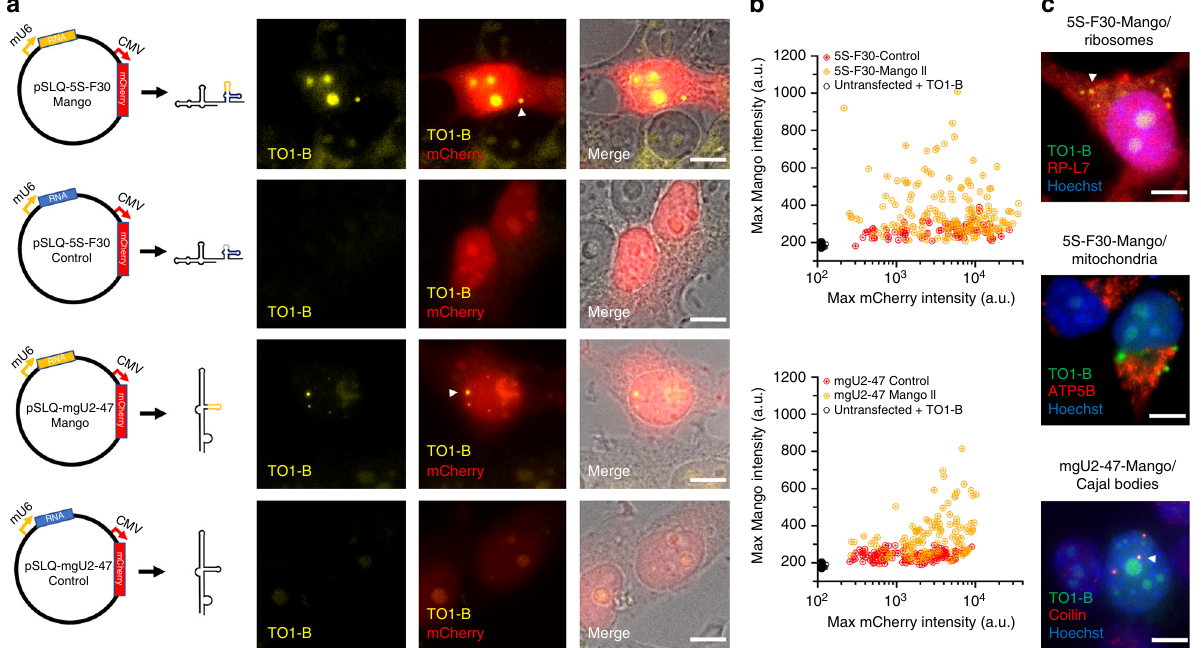
Fig. 5 Cellular imaging of genetically encoded Mango II-tagged RNAs. a Diagram of plasmid constructs with the 5S rRNAs and mgU2-47 scaRNAs under the control of a murine U6 promoter (Pol III) and co-expression of a mCherry reporter gene (CMV promoter). Shown adjacent are images of individual slices of fi xed cells either expressing Mango II-tagged RNAs (top) or control RNAs (bottom) with the TO1-B (200 nM) signal in yellow, mCherry in red and bright fi eld image in greyscale. Arrows depict signi fi cant cellular and nuclear foci. Scale bar = 10 µ m. b 2D maximum intensity plots of individual nucleoli and Mango II speci fi c foci for both the TO1-B signal ( y axis) and mCherry signal ( x axis — log 10 scale). The number of cells for 5S-F30-Control, 5S-F30-Mango II, untransfected cells + TO1-B, mgU2-47 Control and mgU2-47 Mango II were 89, 167, 98, 130 and 117 respectively. c Maximum projections of cytoplasmic 5S-F30-Mango IV foci and nuclear mgU2-47 foci from plasmid expression in conjunction with immunostained ribosomes (RP-L7), mitochondria (ATP5B) and Cajal bodies (Coilin). Arrows depict signi fi cantly co-localized foci, scale bar = 10 µ